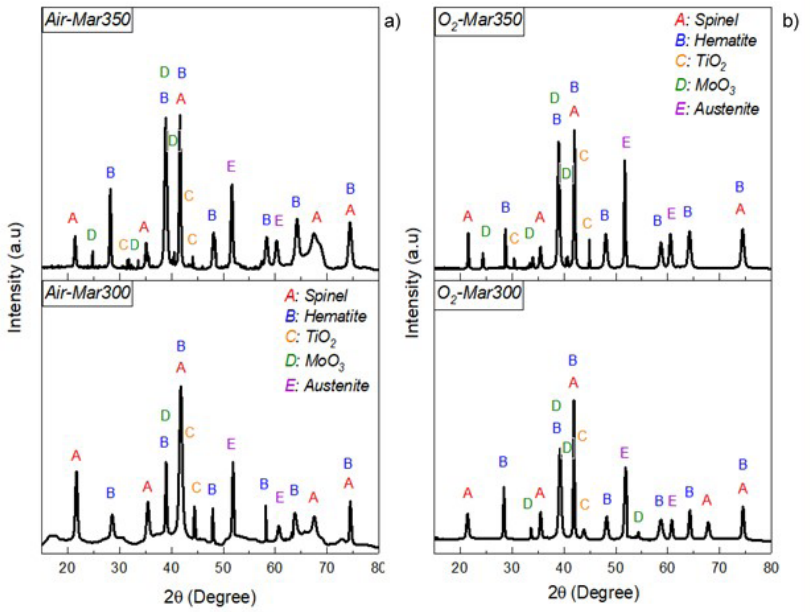
Figure 3. X-ray diffraction spectra of the different oxides produced under different atmospheres for each maraging alloy.